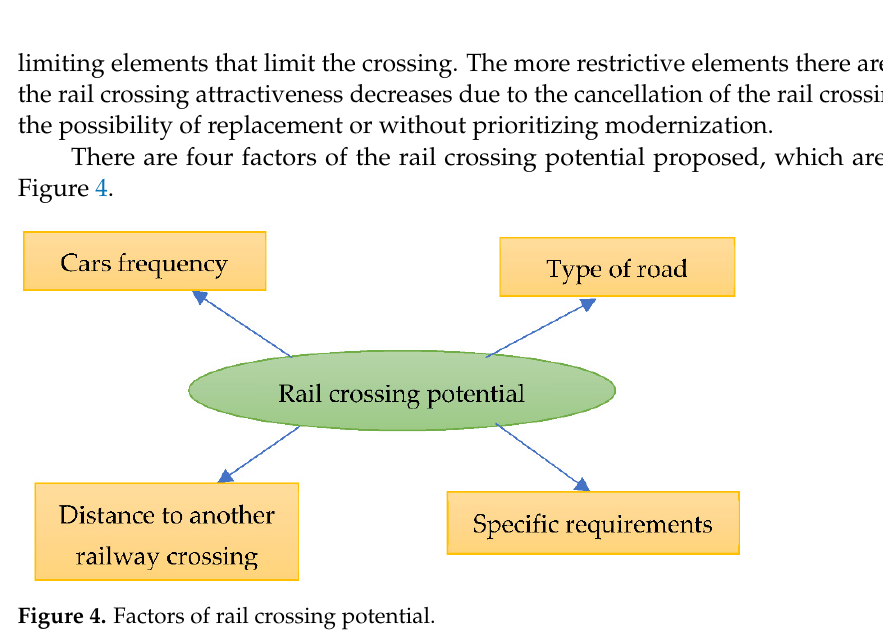
Figure 4. Factors of rail crossing potential.